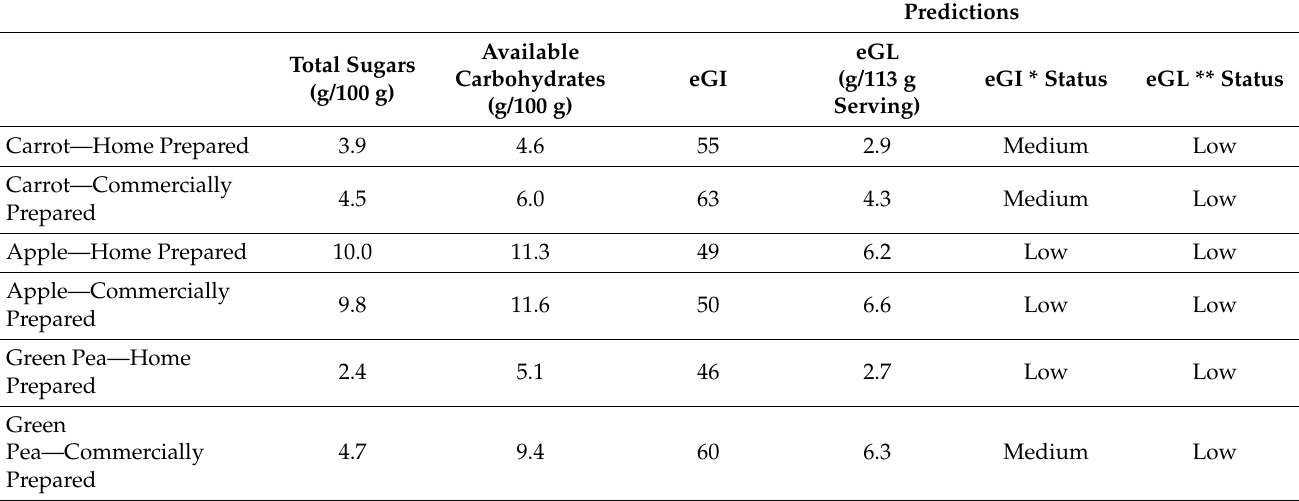
Table 6. eGI/eGL comparison of home prepared and commercially prepared infant purees, adjusted for